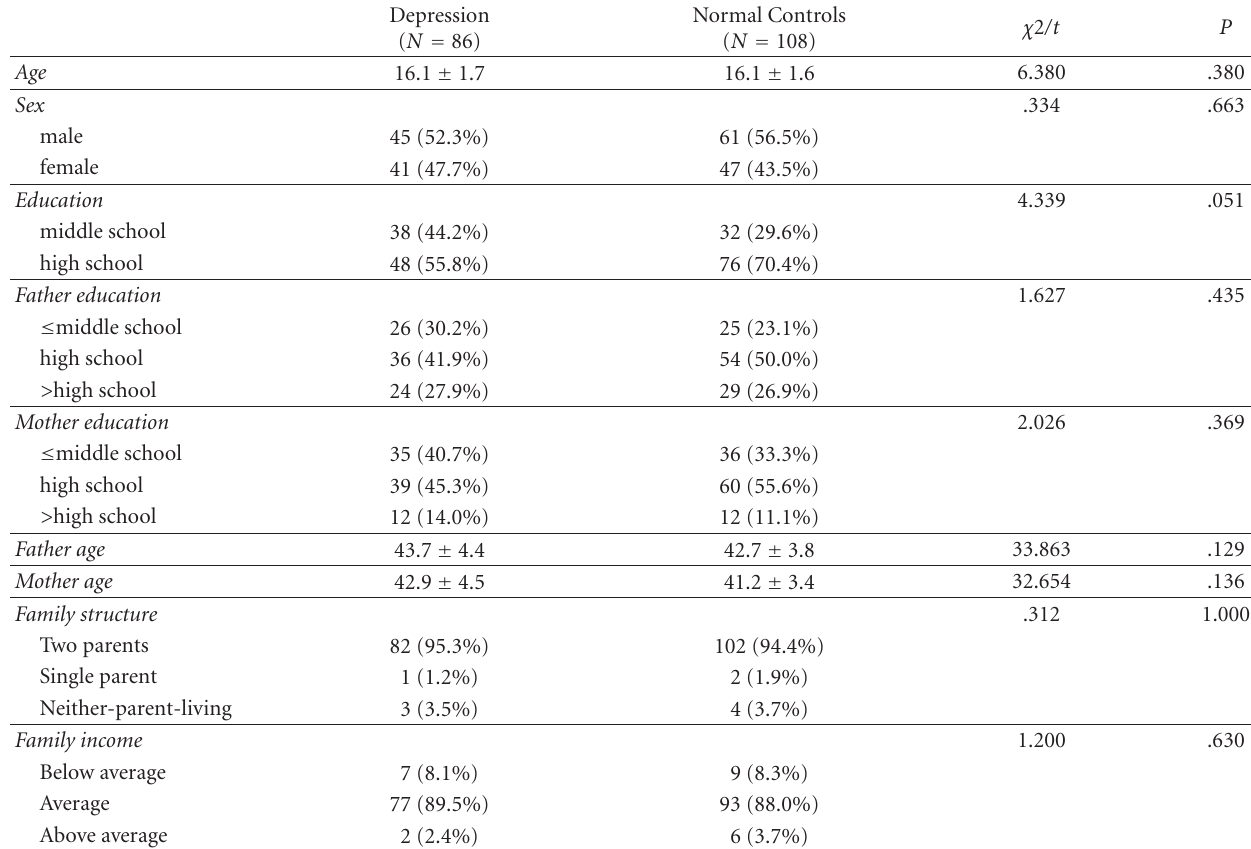
Table 1: Demographic characteristics of study